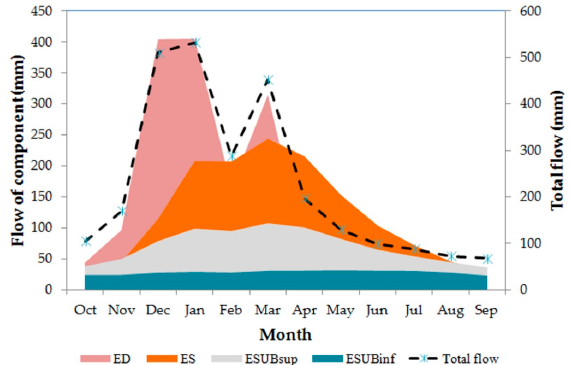
Figure 4. Seasonal distribution of total flow and of stream flow components estimated by the hydrological model. Symbols: ED—surface flow (overland flow due to sealing or saturation excess), ES—fast interflow (percolation within the upper soil layer); ESUBsup—fast baseflow (usually from the weathering part or fissures if existing); ESUPinf—base flow from base rock. Total flow = ED + ESUBsup + ESUBinf. The values represented in mm were calculated as amount of flow (m 3 ) divided by HRU area (m 2 ).